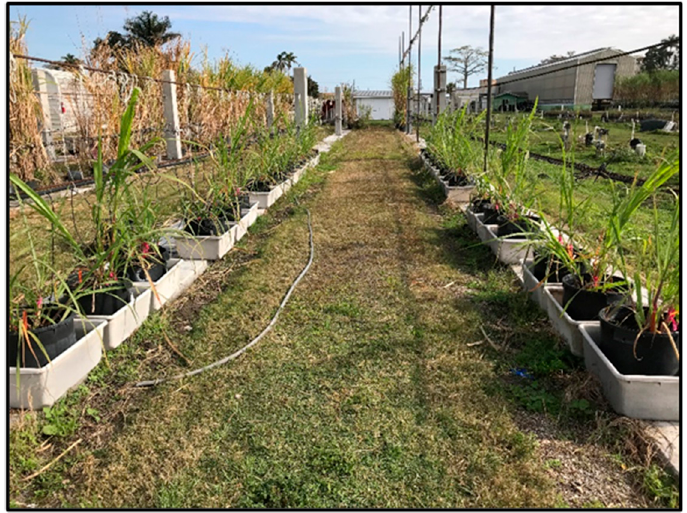
Figure 1. Potted plants of two sugarcane cultivars (Canal Point (CP) 00-1101, CP 96-1252) and an Erianthus in the containers for different salinity treatments.